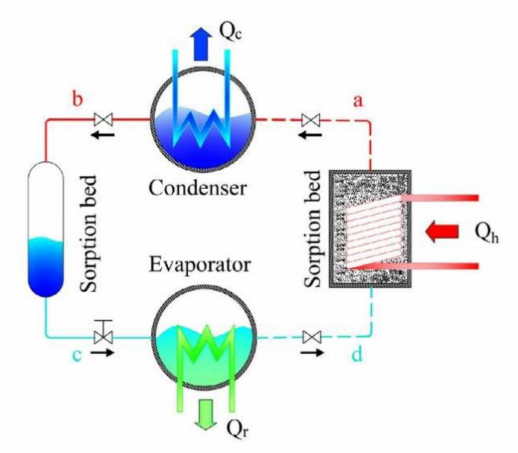
Figure 19. Schematic sorption refrigeration cycle: heating of sorption bed (desorption phase in red line, a , b ) and cooling of sorption bed (sorption phase in light blue line, c , d ). Adapted from ref. [60], Copyright (2018), with permission from Elsevier.